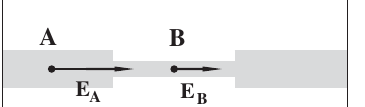
FIG. 7. The electric field at a point outside the thin section is greater than the electric field at a point inside the thin